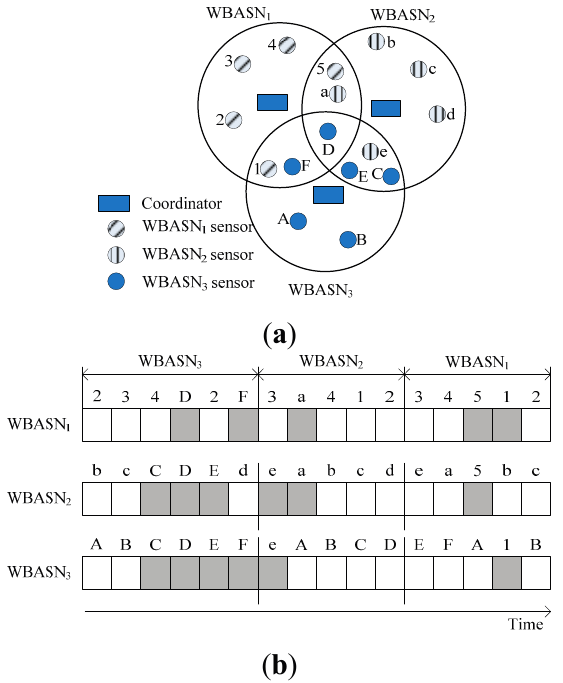
Figure 3. ( a ) An example of interference among WBASNs; and ( b ) channel assignment in